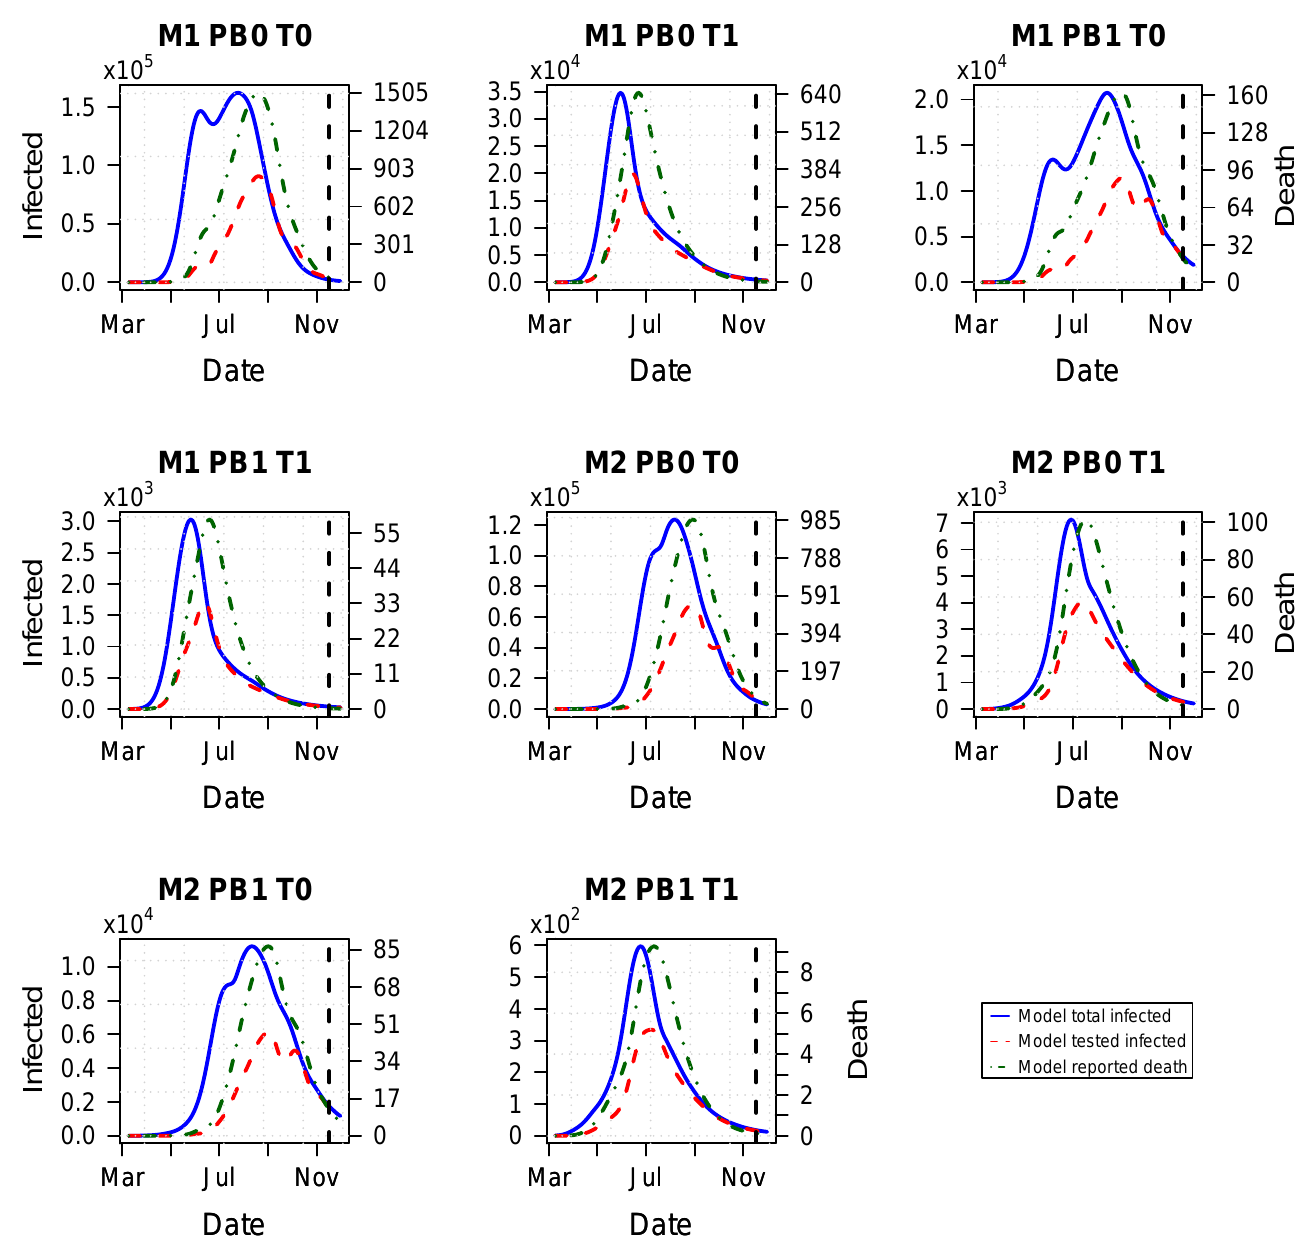
Figure 8. The posterior predictive mean for the various intervention scenarios for